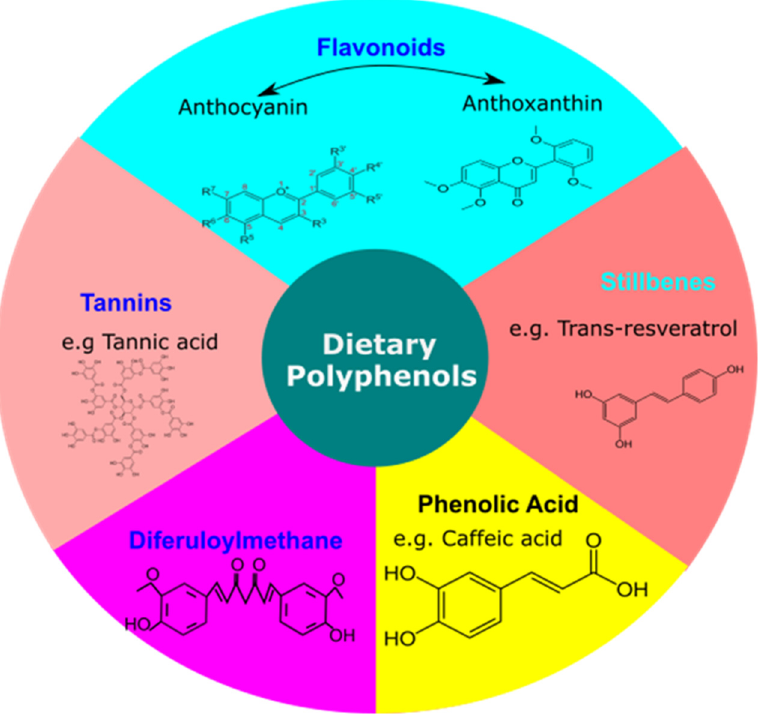
Figure 3. Classification of Dietary Polyphenols. Basic classification includes flavonoids (Anthocya- nin, Anthoxanthin), stilbenes (Trans-resveratrol), phenolic acid (caffeic acid), diferuloylmethane, tannins (tannic acid).